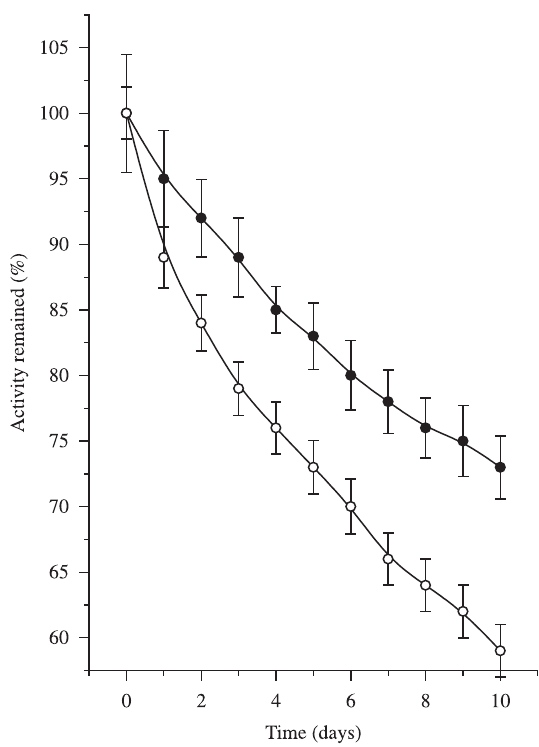
Figure 8. Stability of PGLD-GOx/PANINT´s ( ● ) and CHD-GOx/PANINTs ( ○ ) glucose biosensors at NaPBS 0.1 M, pH 7.4 and 25 °C. The error bars represent standard deviations between five